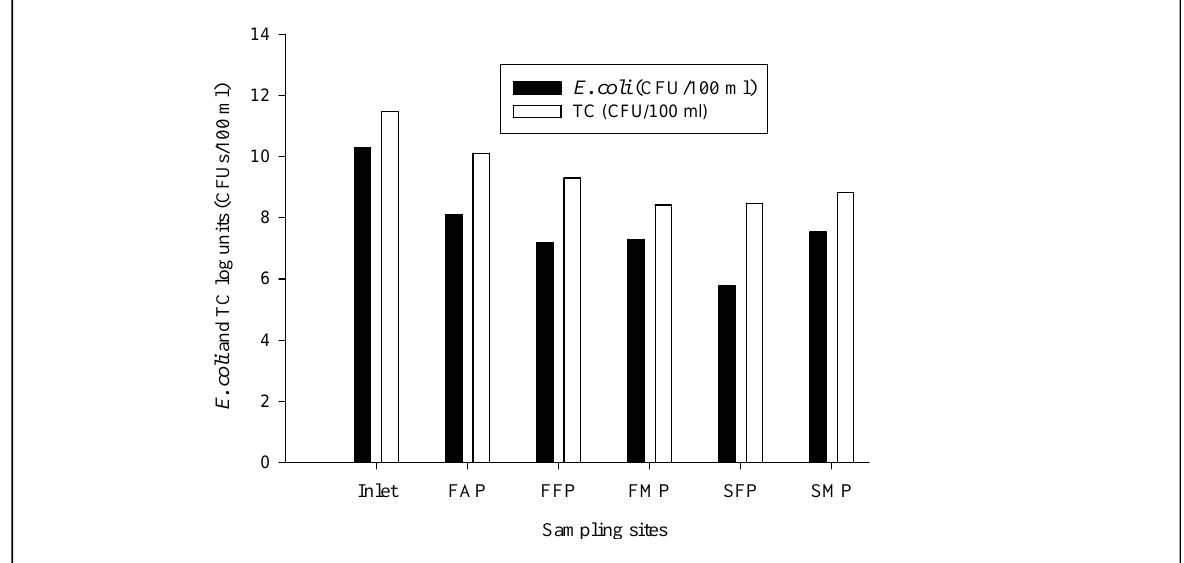
Figure 3: Spatial variation in concentration of E. coli and TC and in WSPs. Bars represent log units for TC and E. coli counts. Key: FAP = First Anaerobic Pond, FFP = First Facultative Pond, FMP = First Maturation Pond, SFP = Second Facultative Pond, and SMP = Second Maturation